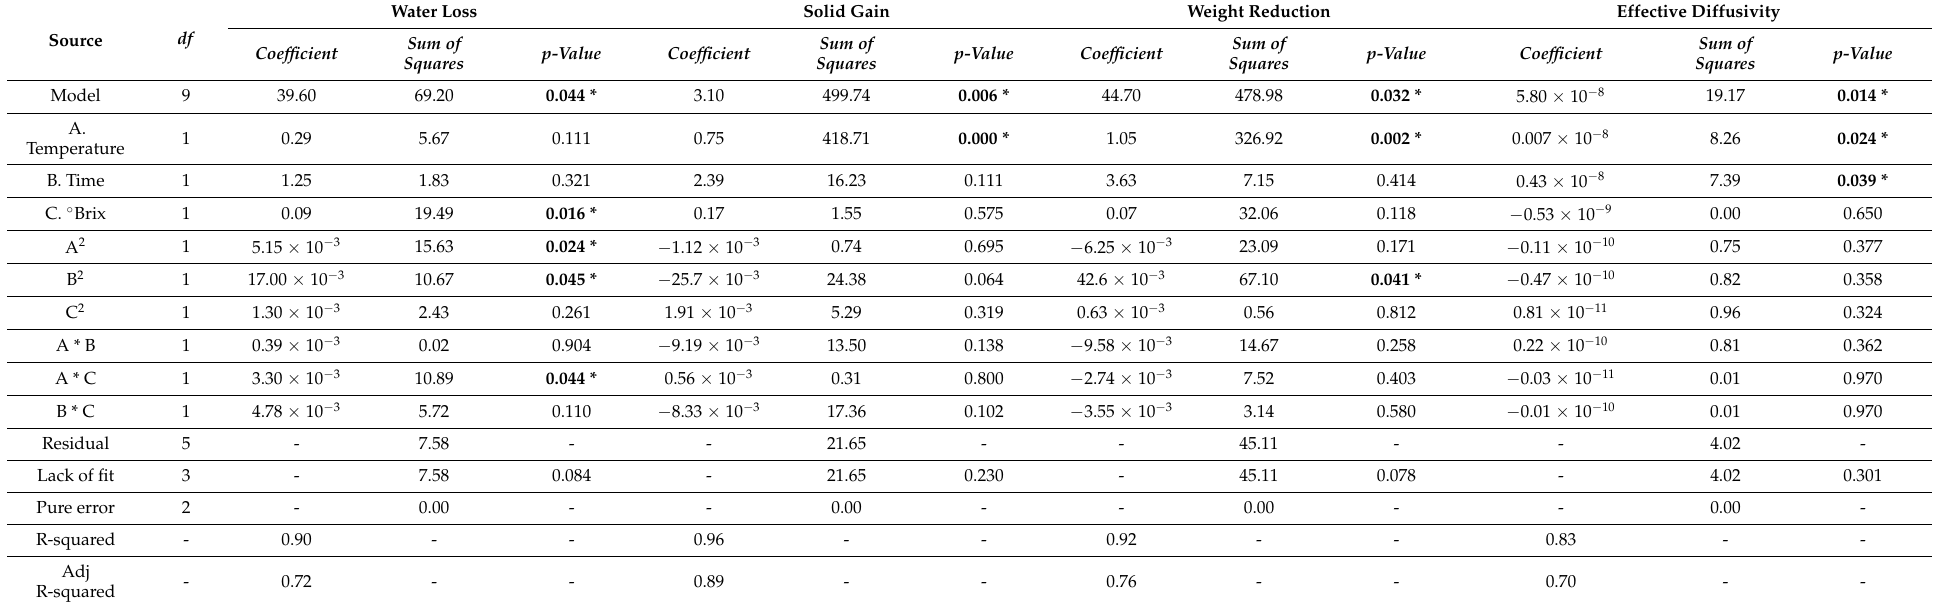
Weight Reduction Effective